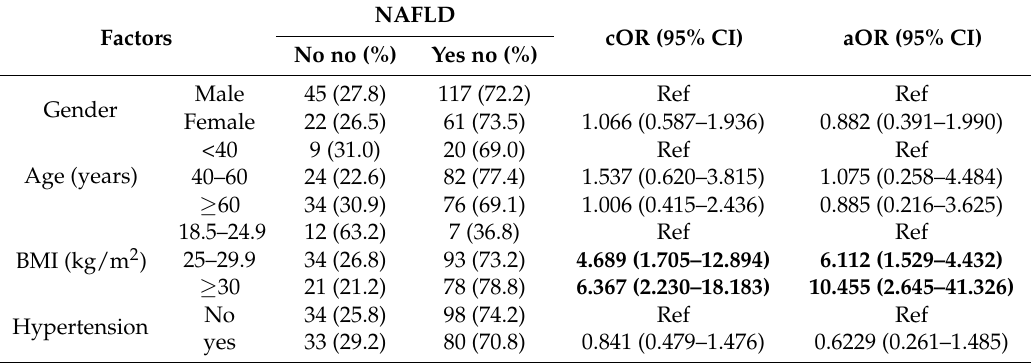
Table 1. Personal and clinical factors associated with NAFLD among the study sample of T2DM patients ( n = 245).